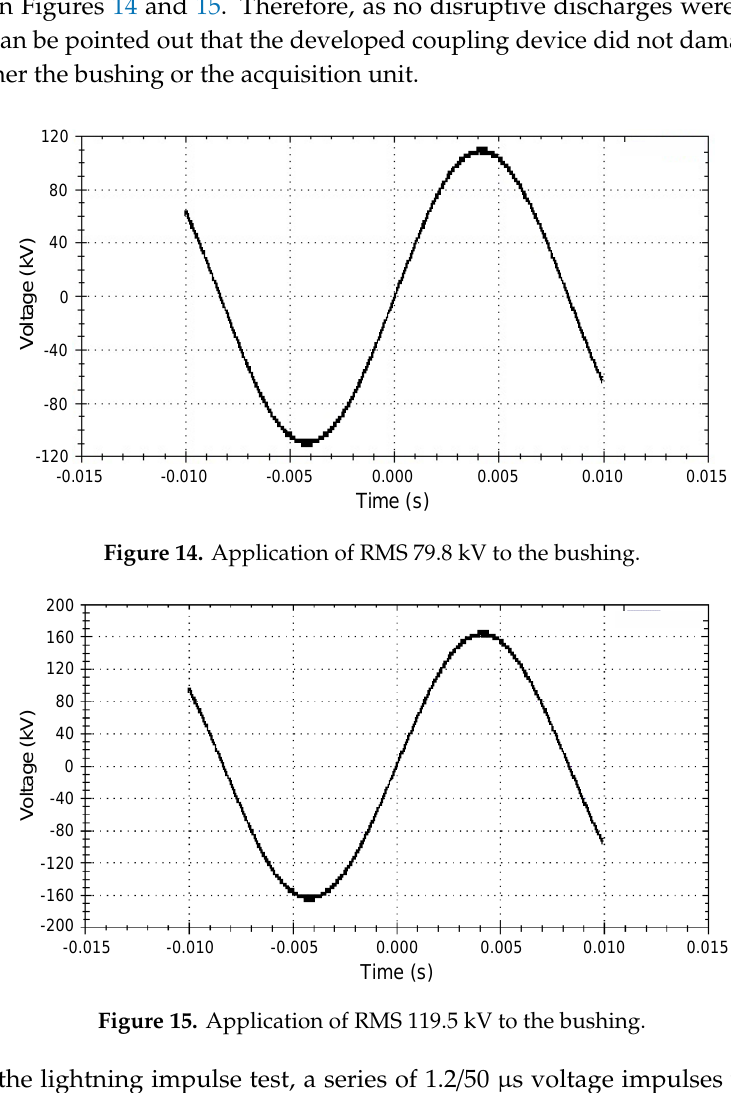
Figure 16. Application of a 1.2/50 µs impulse at bushing’s terminal with peak of −356 kV.